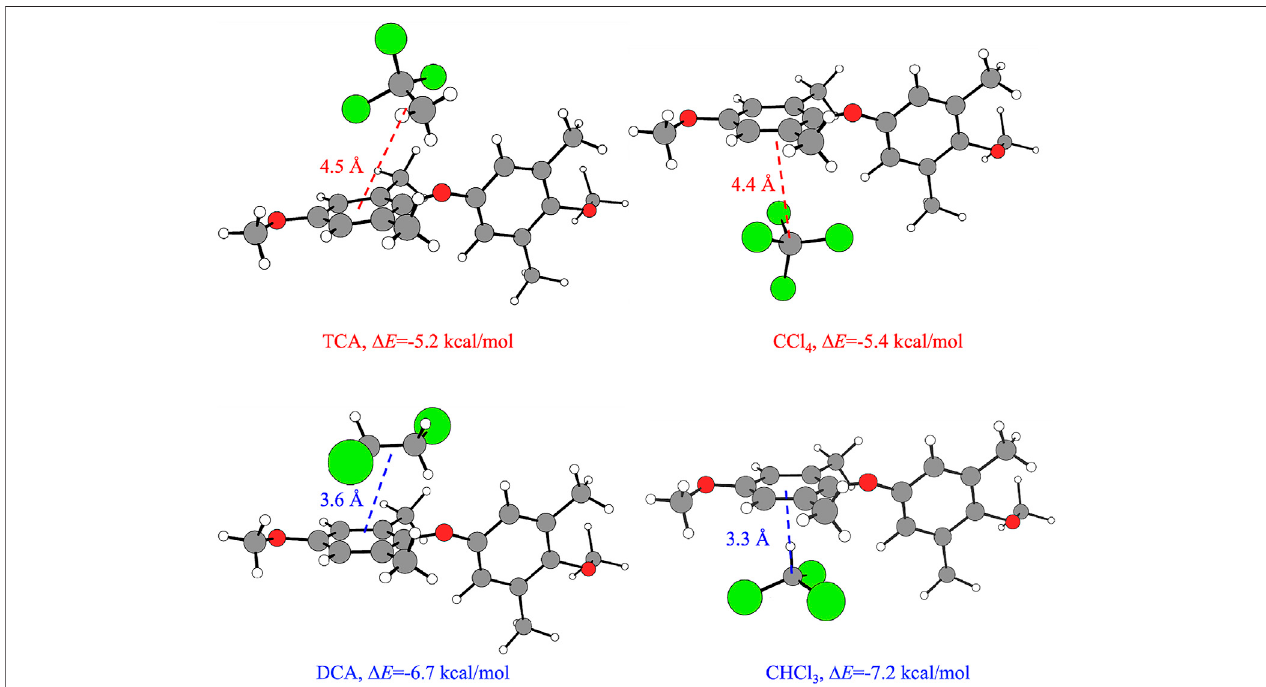
FIGURE5 | Optimized structures ofthe low-energy con fi gurations of thehost – guestadductsobtained from calculations, for the β - and α -forms inducers TCA and CCl 4 (top) and DCA and CHCl 3 (bottom), respectively. In addition, the Δ E values and the distance between CM 1 of the model dimer and the approximate guest center d CM1-guest areindicatedforeachhost – guestadduct.Theguestcenterisapproximatelylocatedonthecentralcarbonatomoftheball-likeguestsCCl 4 andCHCl 3 andthe center of the C-C bond of TCA and DCA. The value of the valence angle τ isarbitrarily set equal to 130 ° . Similar con fi gurations of the host – guestadducts would be obtained regardless of the value of τ . Legend: C of the guest and of the model dimer: light gray; O: red; Cl: green; H: empty spheres.